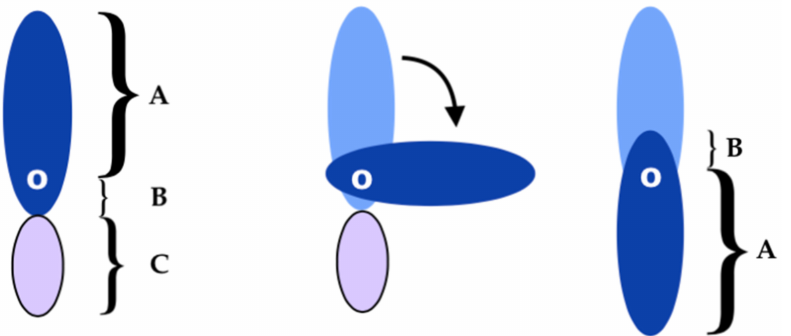
Figure 4. Propeller flap. On the left side, the planning of the elliptical flap. A + B is the flap; O is the pivot point (where the perforator is located) and C is the injury zone receiving the